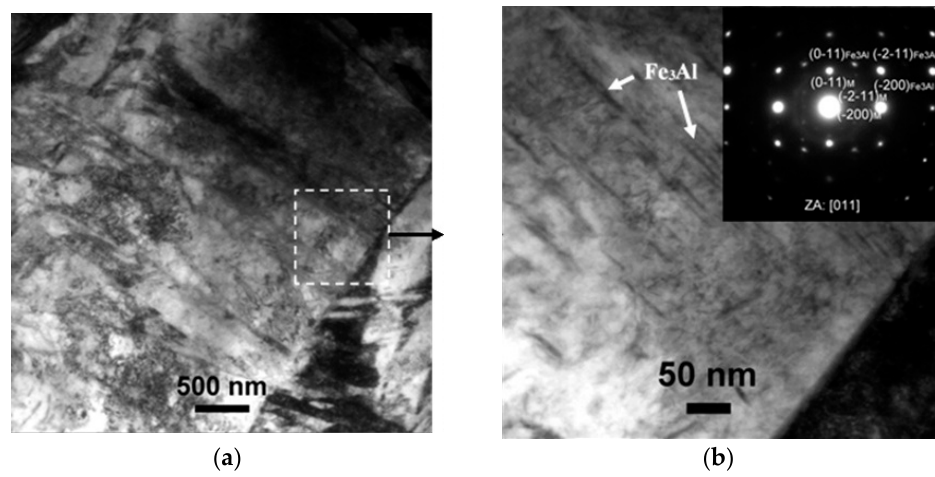
Figure 8. TEM micrographs of ( a ) the martensite structure in direct contact with the coating, ( b ) where some Fe 3 Al precipitates were detected. Inset in ( b ) is the indexed CB-SAEDP of the Fe 3 Al phase (indicated by the arrow in the micrograph).